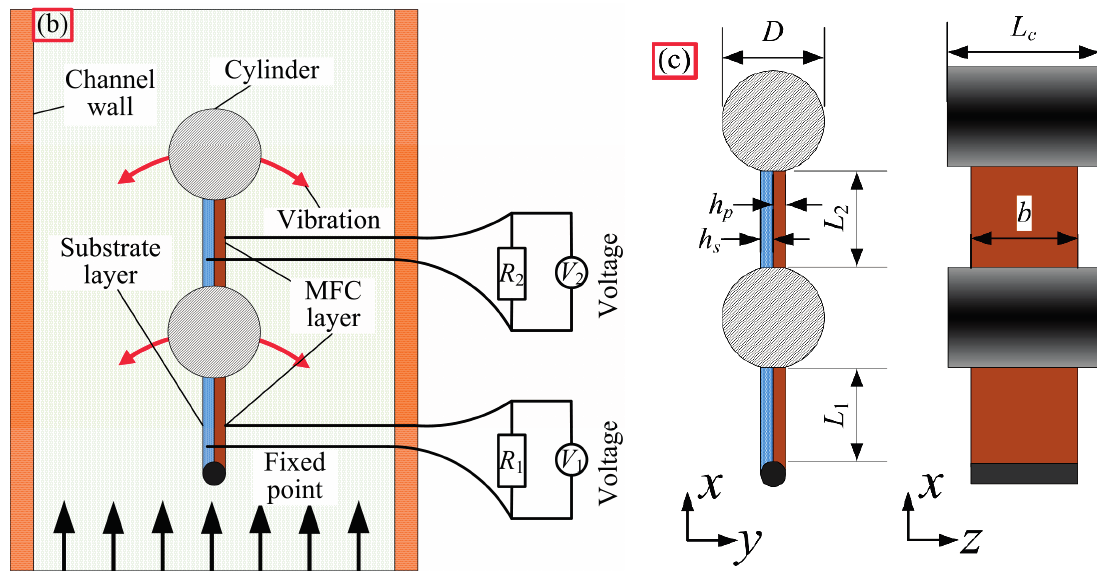
Figure 1. Schematic of the piezoelectric energy harvesting system: ( a ) system diagram; ( b ) schematic diagram; ( c ) dimensional